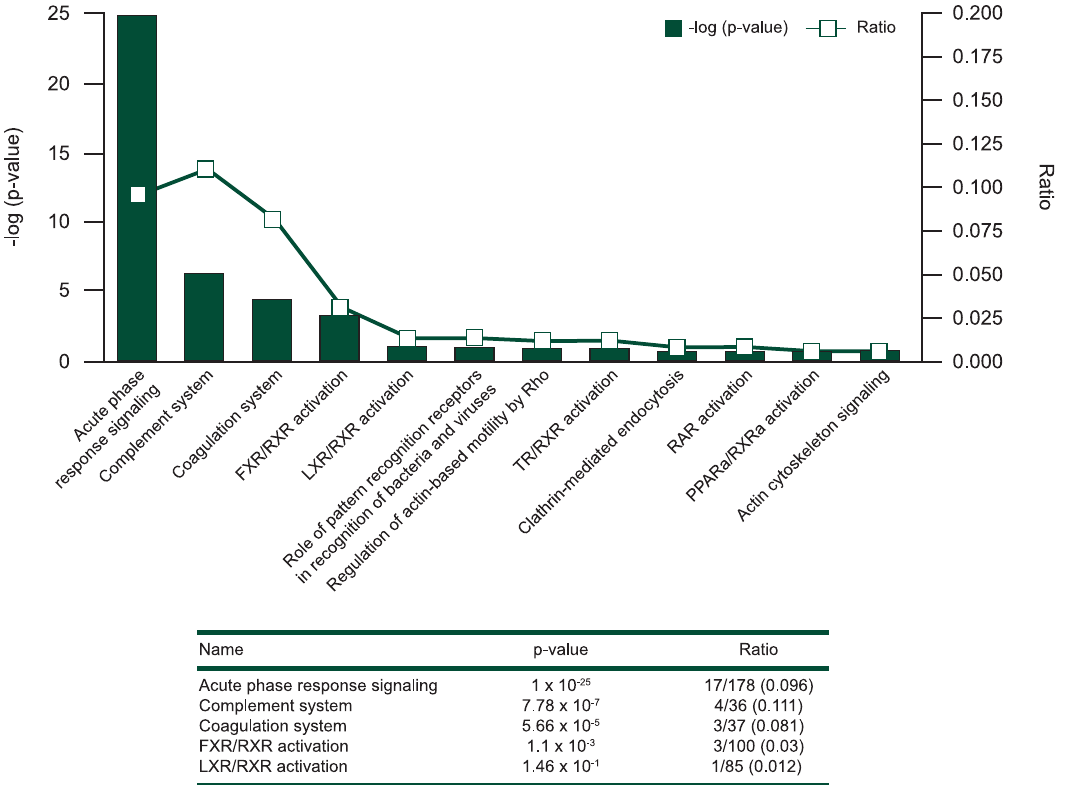
Figure 4. Significant associated pathways with ILD status. The most significant pathways from an analysis linking the identified 29 proteins from the study to curated pathways in the Ingenuity Pathway Analysis system are shown, ordered according to the ratio between the number of protein markers that can be associated with the pathway and the number of proteins in the pathway.